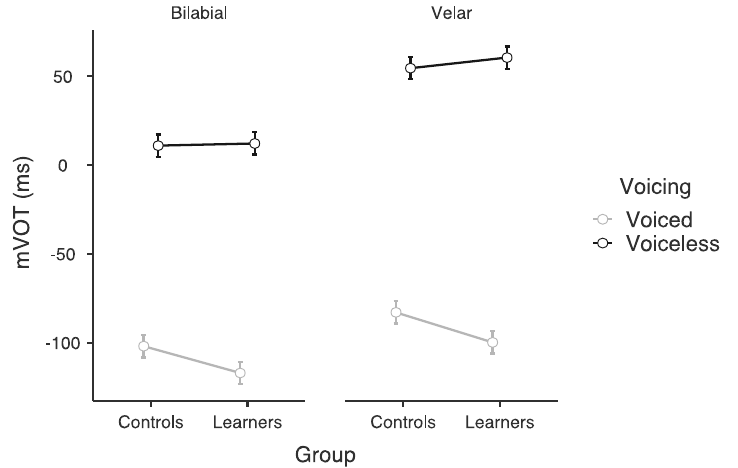
Figure 1. Mean (and 95% CI) of Portuguese mVOT values plotted as a function of place (bilabial, velar), voicing (voiced, voiceless), and speaker group (EFL learners, controls). Data come from 56 native speakers of Portuguese, 28 of whom are foreign language learners of English.